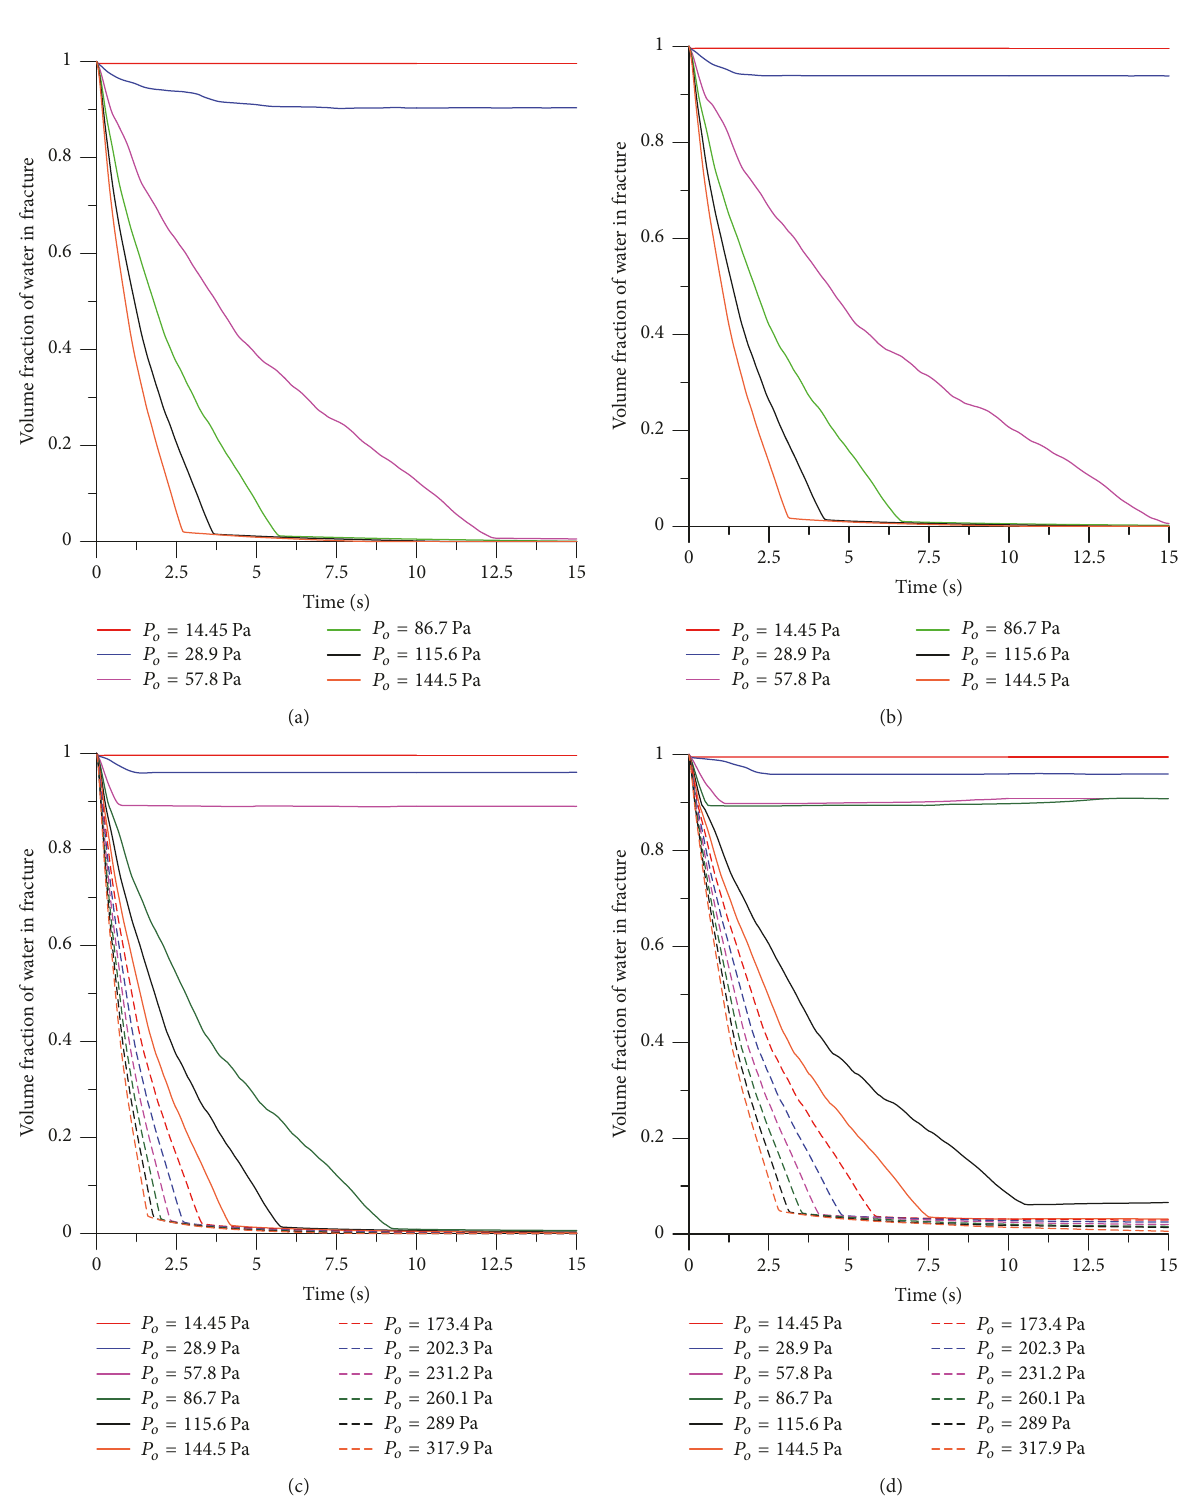
Figure 8: Volume fraction of water for different roughness fractures during drainage: (a) FD = 2.1; (b) FD = 2.2; (c) FD = 2.3; (d) FD =